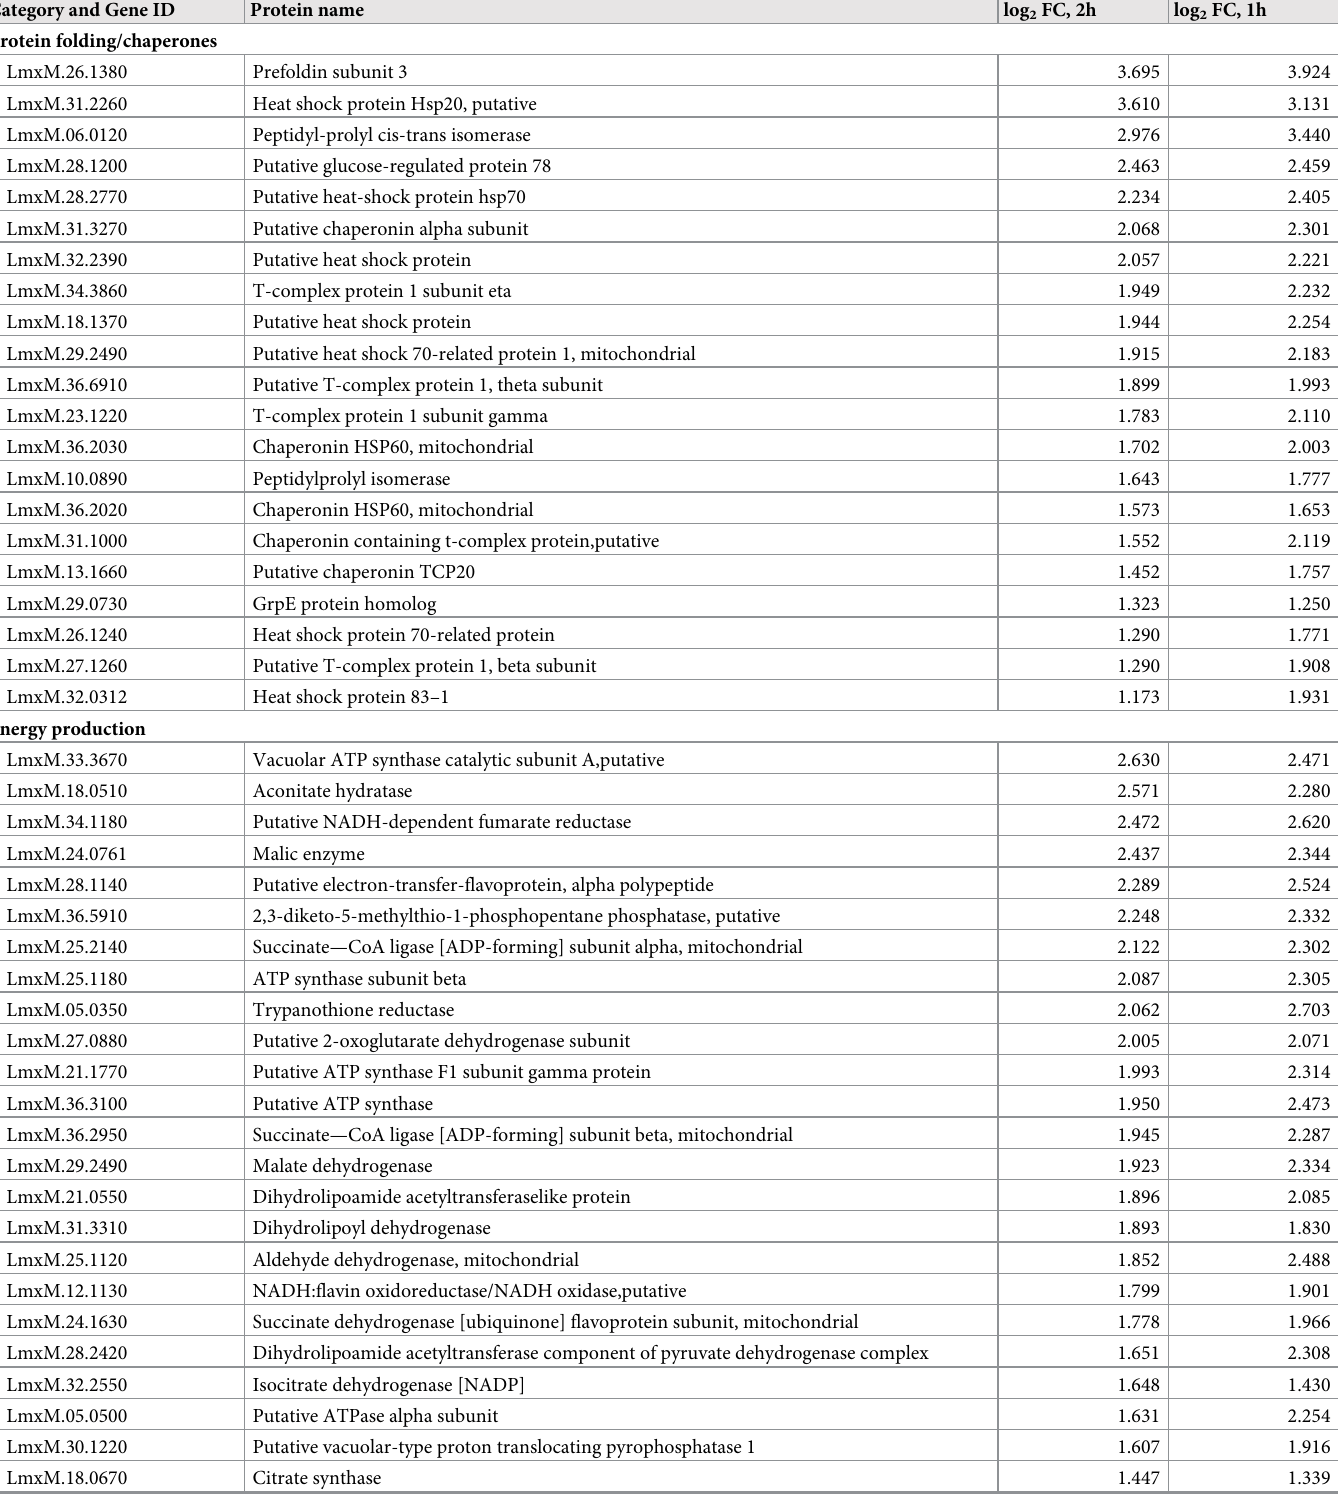
Table 1. List of starvation-responsive NSPs by selected functional groups a